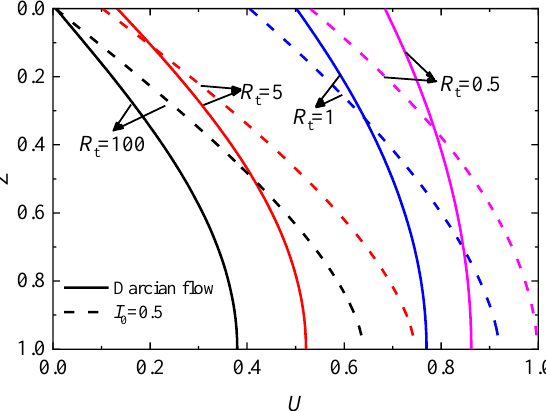
Figure 5. Darcy’s law and non-Darcian flows under a single-sided impeded drainage boundary ( R b = 0, T = 0.5).